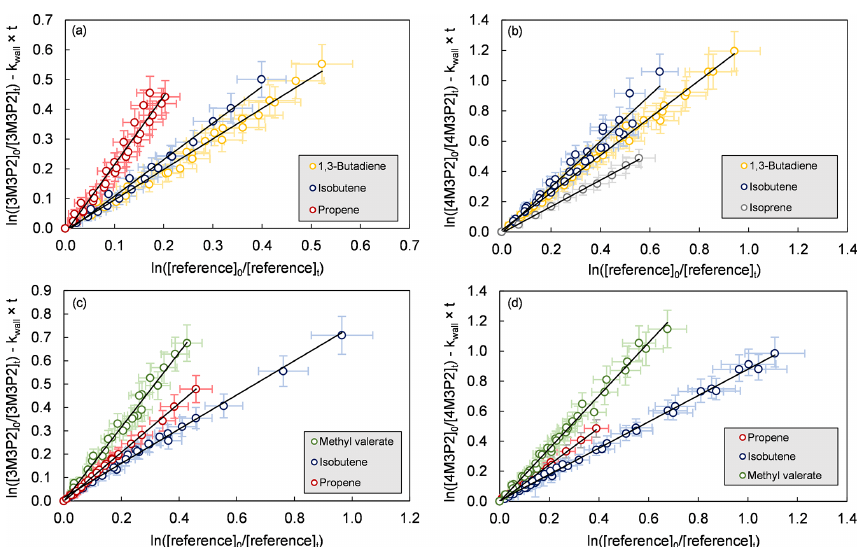
Figure 1. Relative-rate plots of all experiments according to Eq. (1) for the reaction of (a) 3-methyl-3-penten-2-one + OH, (b) 4-methyl-3-penten-2-one + OH, (c) 3-methyl-3-penten-2-one + Cl and (d) 4-methyl-3-penten-2-one + Cl. The error bars consist of a systematic uncertainty and an additional 10% relative error to cover uncertainties derived from the experimental and evaluation procedure, respectively. Table 2. Results of the kinetic study using different reference compounds. Reaction Reference Number of Ketone Ketone k carbonyl /k ref. k × 10 11 / runs [ ppm ] 0 max. consumption cm 3 molecule − 1 s −